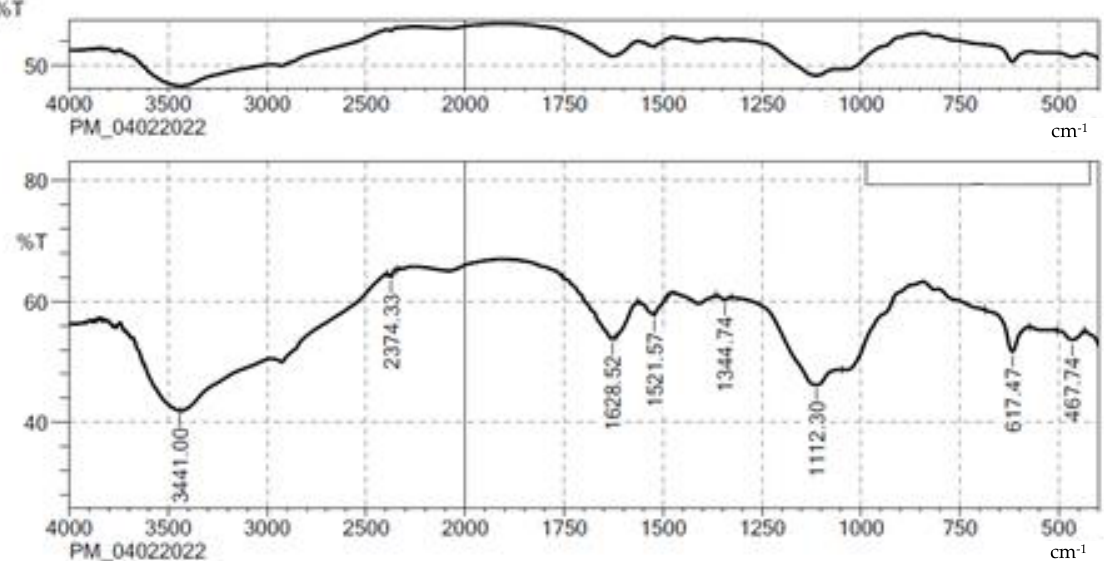
Figure 2. FTIR spectra of physical mixture of NES + all ingredients.